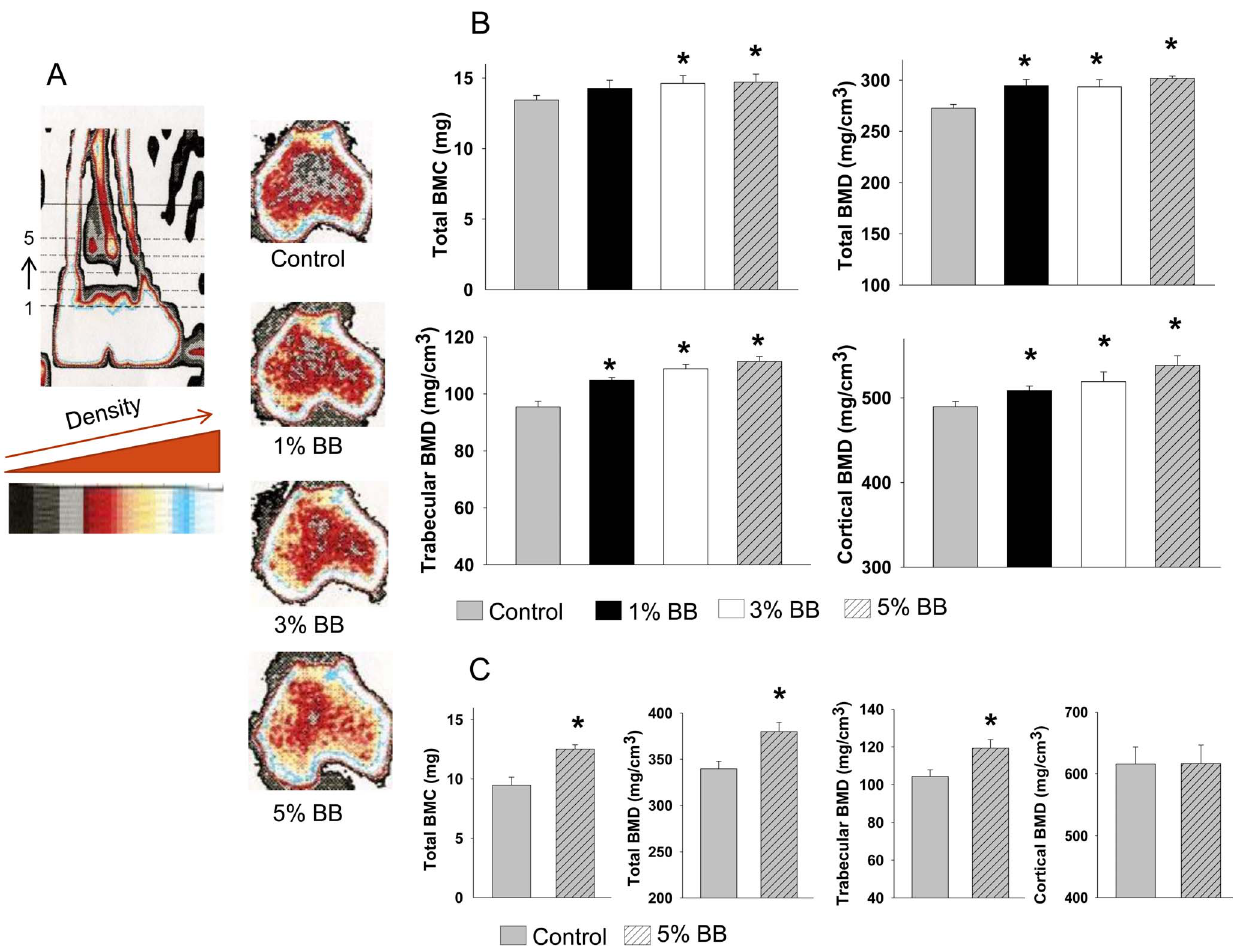
Figure 2. Bone mass in BB and non-BB diet rats. (A) Scout view of rat tibia using peripheral quantitative computer tomography (pQCT). Five consecutive slices (1 through 5, 1 being most distal) from each tibia were scanned using a STRATEC XCT Research SA + pQCT machine in a blinded fashion. Each slice was separated by 1 mm. software (v. 5.4) thresholds of 570 mg/cm 3 to distinguish cortical bone and 214 mg/cm 3 to distinguish trabecular from cortical and sub-cortical bone were used in analyzing pQCT scans slices analyzed presents those closest to the tibial growth plate. Representative tibial pQCT scans (slice 3) from control and three different BB diet rats are shown in this panel. Color changes from blue, yellow, red to gray represent decreases in bone density. (B) pQCT from four different groups of rats with BB or non-BB diet feeding. Five consecutive slices (start from about 1 mm below tibial growth plate) from each rat tibia were scanned, and data were presented after combining slice 2 and 3. Tibial trabecular bone mineral density (BMD), tibial cortical BMD, total tibial BMD and total tibial bone mineral content (BMC) were presented. (B) Tibial pQCT scan data from non BB and 5% BB diet rats with TEN (total enteral nutrition) feeding. Bars represent means 6 standard error; n=10 animals/ group. *, p , 0.05 versus control by t test. Dose response was assessed using Cruzick’s non-parametric test for